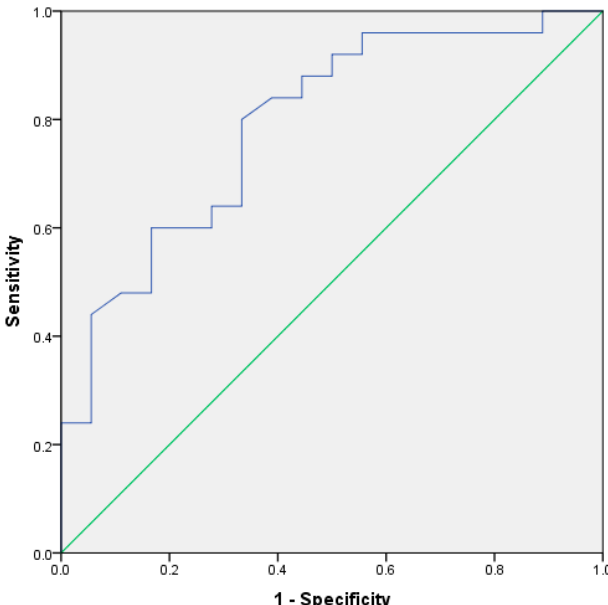
Figure 2. Receiver operating characteristic curve for adenosine deaminase assay to predict tuberculous pleural effusion.